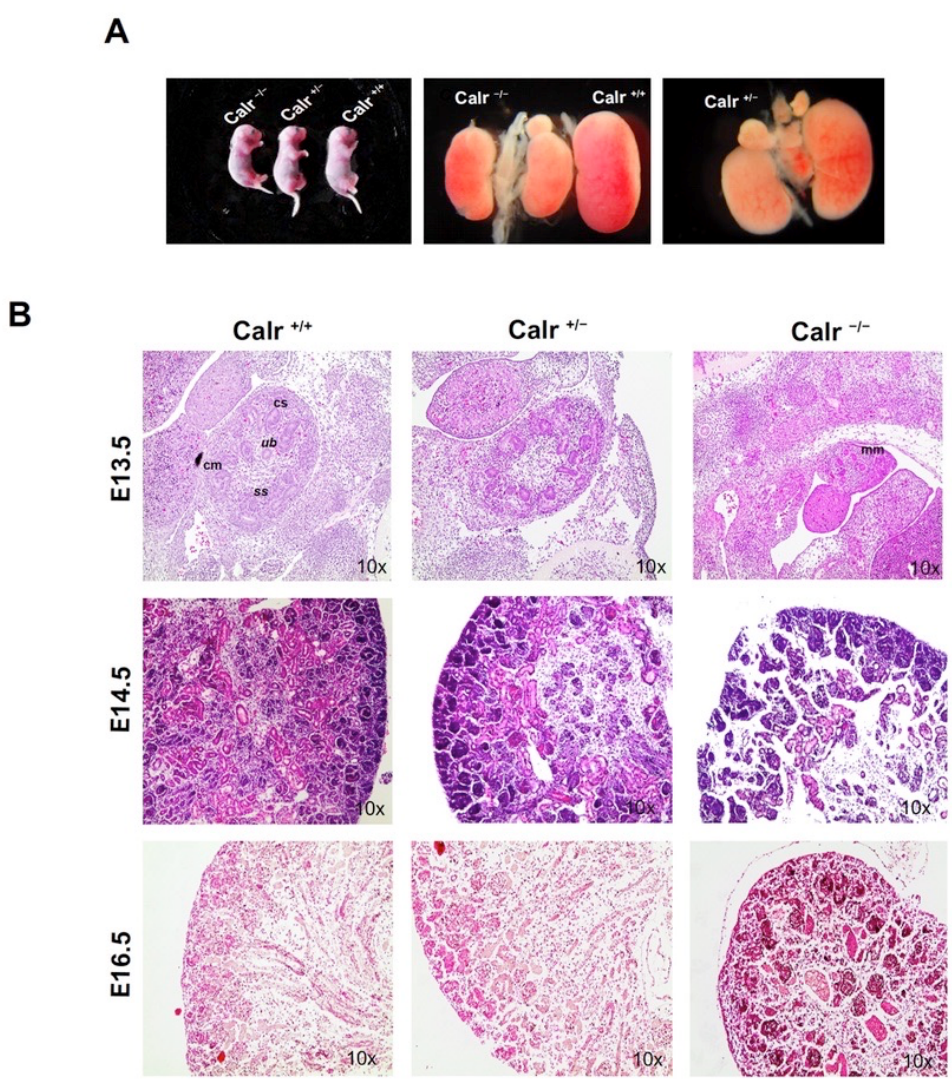
Figure 1. Calr − / − embryos and embryonic kidney displaying abnormalities. ( A ): Mouse embryos from the three different genotypes showing abnormal Calr − / − embryos. The comparison of the size and phenotype of embryonic kidneys from the three different genotypes revealed an alteration in nephrogenesis in Calr − / − mouse embryos. ( B ): HE/PAS staining of embryonic kidney sections from different embryonic stages (E13.5, E14.5, and E16.5) and from the three genotypes (Calr +/+ , Calr +/ − , and Carl − / − ) showing the metanephros, including the outgrowth of the ureteric bud (ub), comma-shaped (cs), s- shaped body (ss), cap mesenchyme